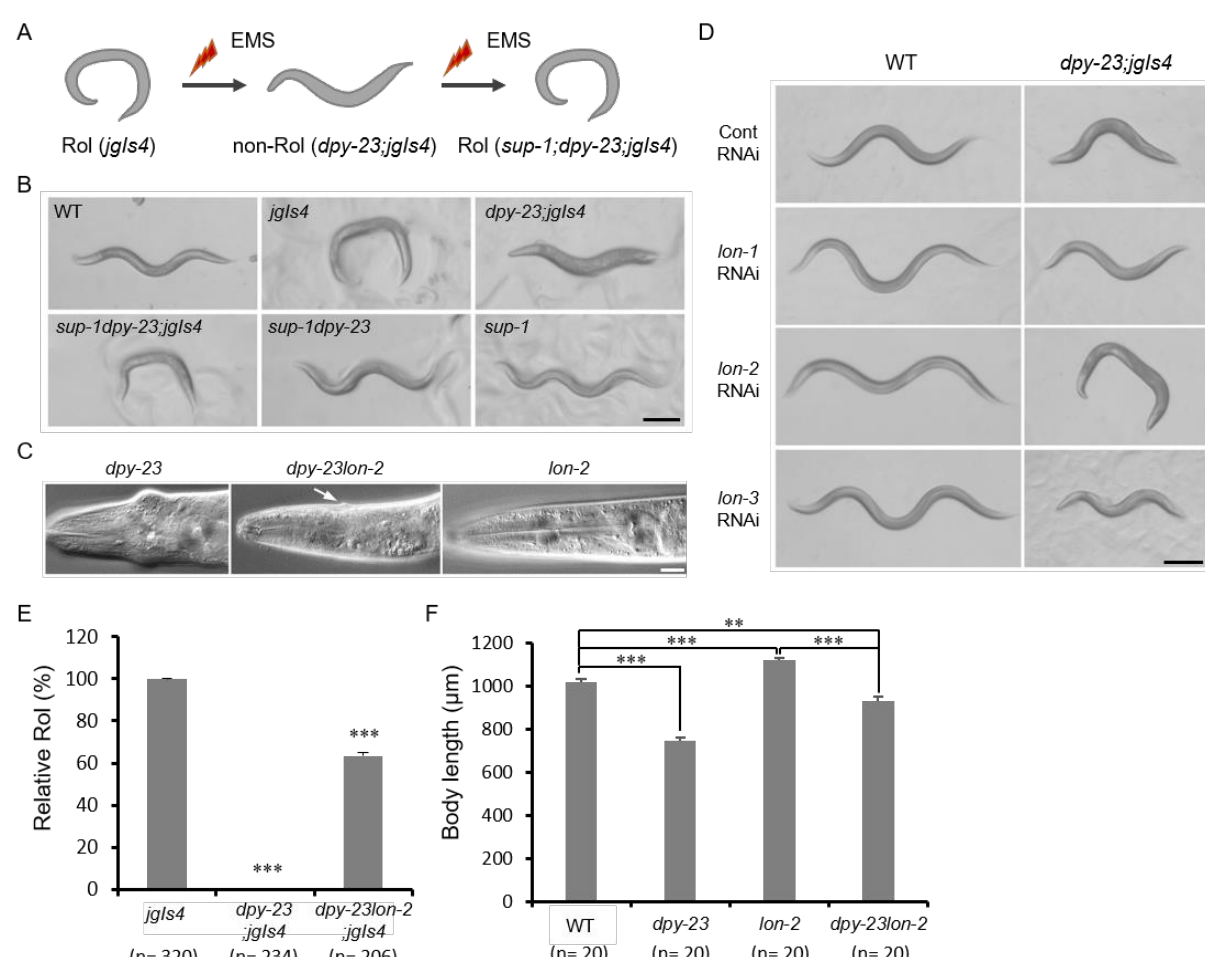
Figure 2. Suppression of the dpy-23 mutant by the lon-2 mutation. ( A ) The screening procedure of Rol and dpy-23 suppressors using ethyl methane sulfonate (EMS). The suppressor-1 ( sup-1 ) mutant recovers Rol. ( B ) The jgIs4, dpy-23; jgIs4, sup-1dpy-23; jgIs4, sup-1dpy-23 and sup-1 mutant strains were observed and compared to the wild type under the dissecting microscope. Scale bar = 200 µ m. ( C ) The head regions of dpy-23, dpy-23lon-2 and lon-2 were compared. The arrow indicates the reminiscence of the Jowls phenotype. Scale bar = 20 µ m. ( D ) The wild-type and dpy-23; jgIs4 strains were treated with each RNA interference (RNAi) for the indicated lon genes and control (Cont) to examine dpy-23 suppression. Scale bar = 200 µ m. ( E ) Rol ratios of the jgIs4, dpy-23; jgIs4 and dpy-23lon-2; jgIs4 strains were compared. Error bar = SEM. *** p < 0.001 versus jgIs4 . ( F ) Body lengths of the wild-type, dpy-23, dpy-23lon-2 and lon-2 strains were measured. Error bar = SEM. ** p < 0.01 and *** p < 0.001. These experiments were repeated more than three times and each result exhibited the same